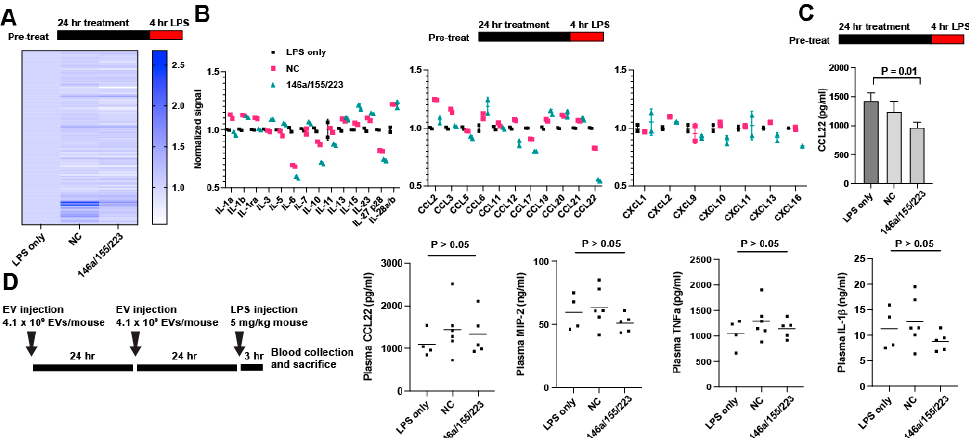
Figure 4 Figure 4. Screen for extracellular protein targets of the miR 146a/155/223 combination. ( A ) Relative expression for all targets as measured by the Proteome Profiler Mouse XL Cytokine Array (R&D Systems) ( n = 2). ( B ) Relative expression for the IL, CCL, and CXCL cytokines. ( C ) CCL22 expression was quantified via ELISA. Results were analyzed via one-way ANOVA. ( D ) Treatment schedule and serum cytokine levels for endotoxemic mice pretreated with 146a/155/223 or NC as indicated. Results were analyzed via one-way